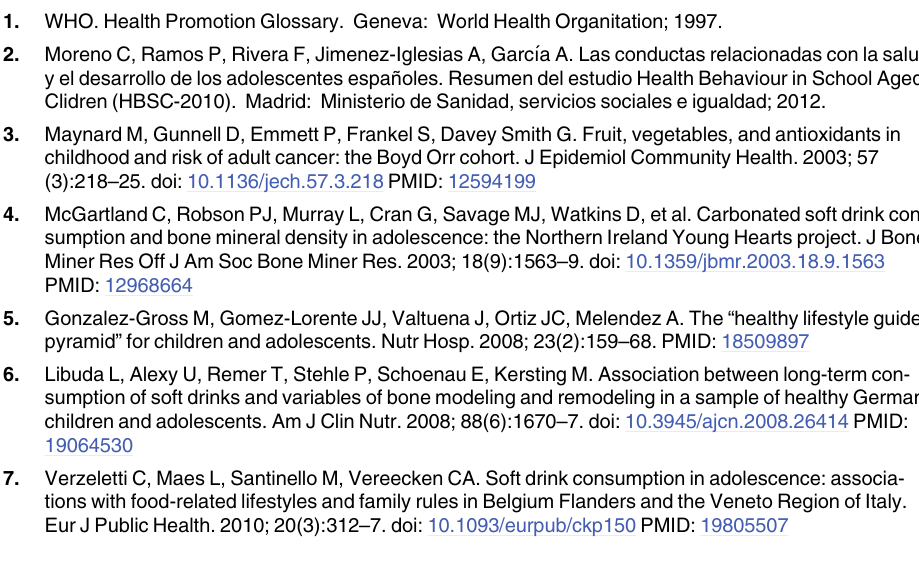
S1 Fig. Total score with respect to age. The red line indicates the general mean. (TIF) S2 Fig. Differences in the lifestyle components with respect to gender, age, location, origin, and family wealth (FAS II). 1 RULT = Rational use of leisure technology; 2 FAS II: Family wealth measured based on the Family Affluence Scale II. Highlighted boxes are where signifi- cant differences were found. The direction of the differences in the score is shown with the mathematical symbols < , > , or =. Higher scores indicate healthier lifestyles in that component. The magnitude of the effect is also indicated with Cohen’s d value. The score tendency is also shown for the age variable. (TIFF) S1 File. Rough data used in our study. A supplementary file with all the data has been uploaded in an Excel file, in order to offer guarantee to access data sources. (XLSX) S2 File. Multivariable